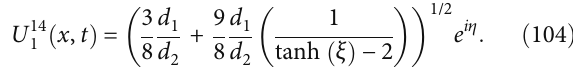
ð x , t Þj for NLFD of order α and for parameters δ 2